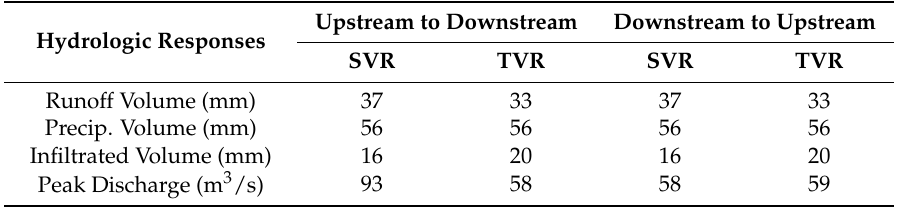
Figure 10. Actual drainage basin, Cowleech Fork of the Sabine River Texas, fully-distributed model (V flo TM ) using pervious conditions, hydrographs at drainage basin outlet for SVR and TVR for ( A ) UtoD and ( B ) DtoU scenarios. Table 4. Summary of hydrologic responses from SVR and TVR for UtoD and DtoU scenarios in Cowleech Fork